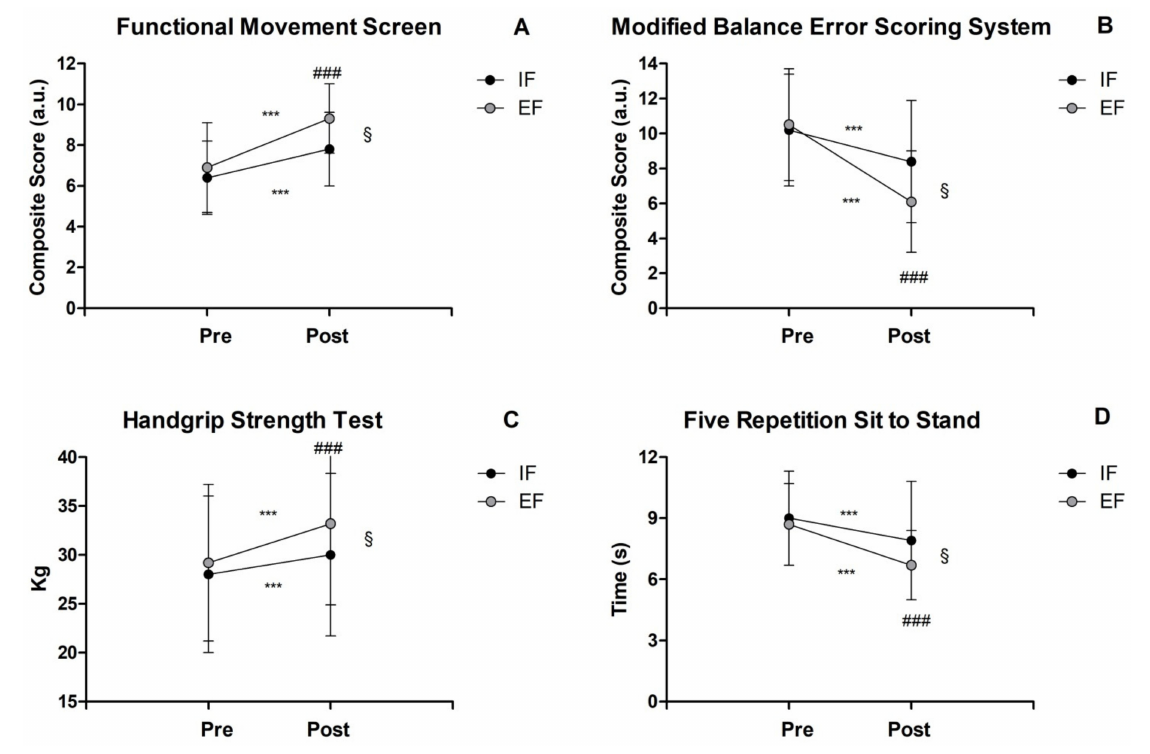
Figure 1. Fitness parameters: ( A ) FMS Composite Score, ( B ) M-BESS Composite Score, ( C ) HST, ( D ) FRSTS. § Significant interaction ( p < 0.001). *** Significant main effect of time before and after testing ( p < 0.001). ### Significant main effect of group (EF vs. IF) ( p <